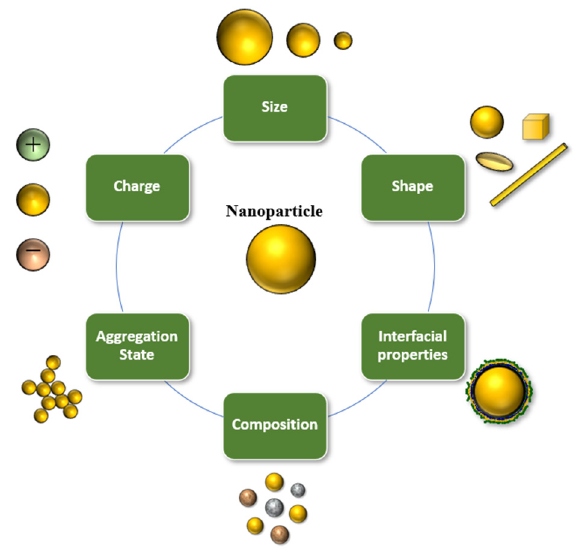
Figure 3. The properties of edible nanoscale delivery systems can be controlled to tailor their func- tionality.